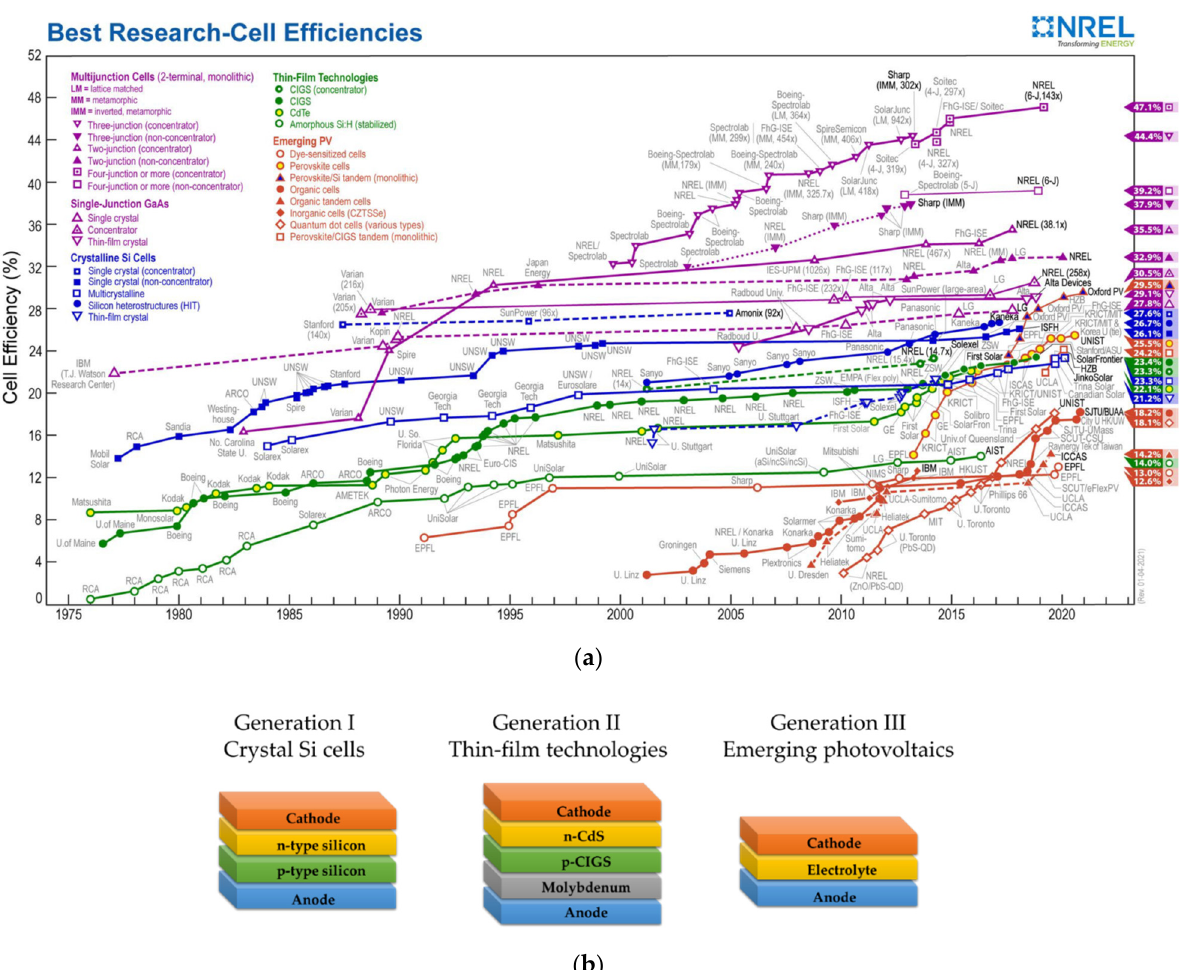
Figure 1. ( a ) A chart of the highest confirmed conversion efficiencies for research cells for a range of photovoltaic technologies plotted from 1976 to the present. (from the national laboratory, NERL, of the U.S. Department of Energy, https://www.nrel. gov/pv/cell-efficiency.html, accessed on 22 March 2021) ( b ) The illustration of three generations of solar cells.